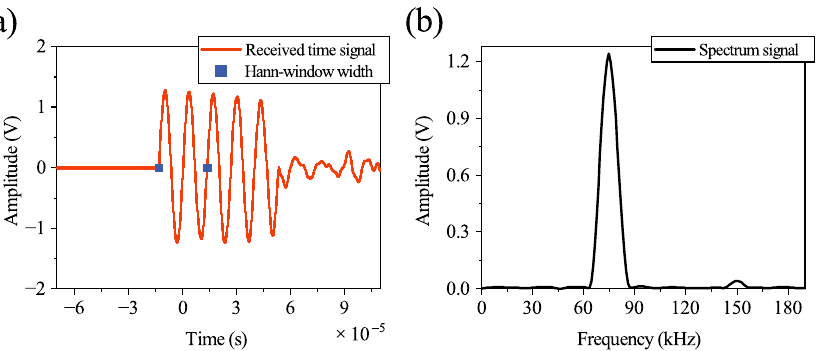
Figure 3. Received signal and spectrum signal in carbonated concrete: ( a ) time-domain signal ( b ) spectrum signal.